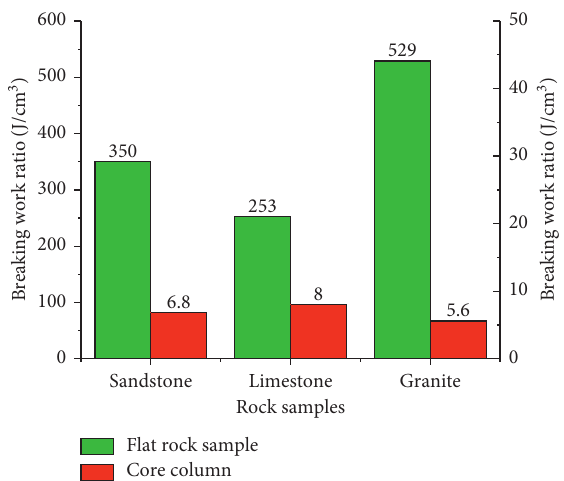
Figure 15: Breaking work ratio of flat rock samples and core columns in the impact experiment.